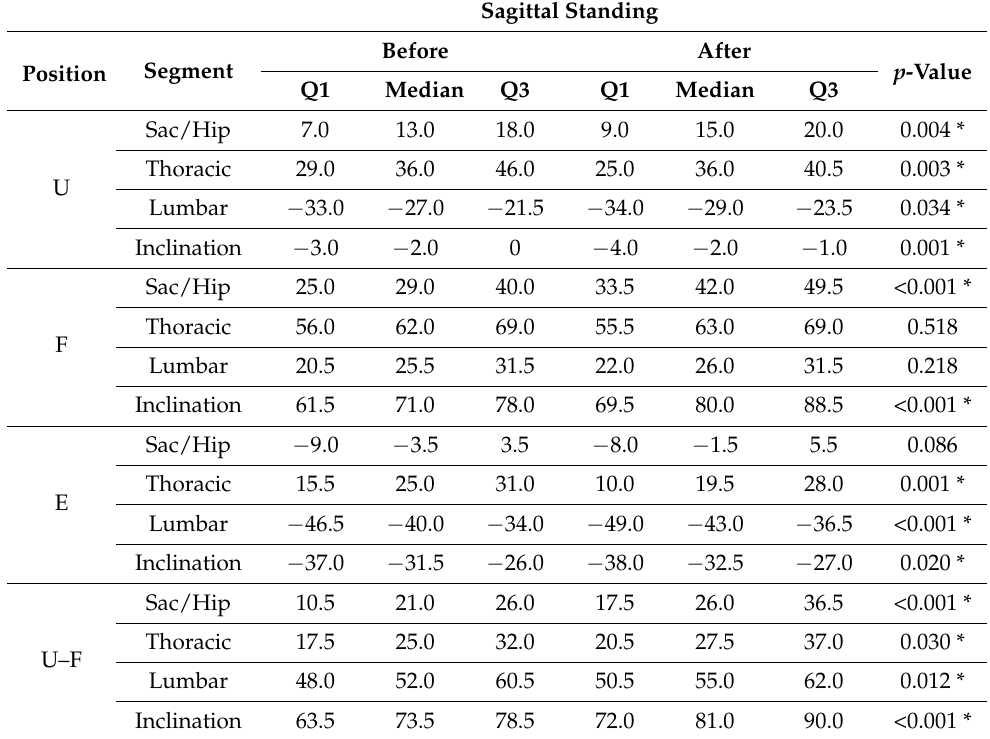
Table 7. Medians and interquartile ranges of total inclination and lumbar, thoracic and sacrum/hip inclinations in degrees measured before and after the intervention in standing position in the sagittal plane: upright (U), flexion (F), extension (E), and estimated ROM from upright to flexion (U-F), upright to extension (U-E) and extension to flexion (E-F) ( n = 76). Sagittal Standing Before After p -Value Position Segment Q1